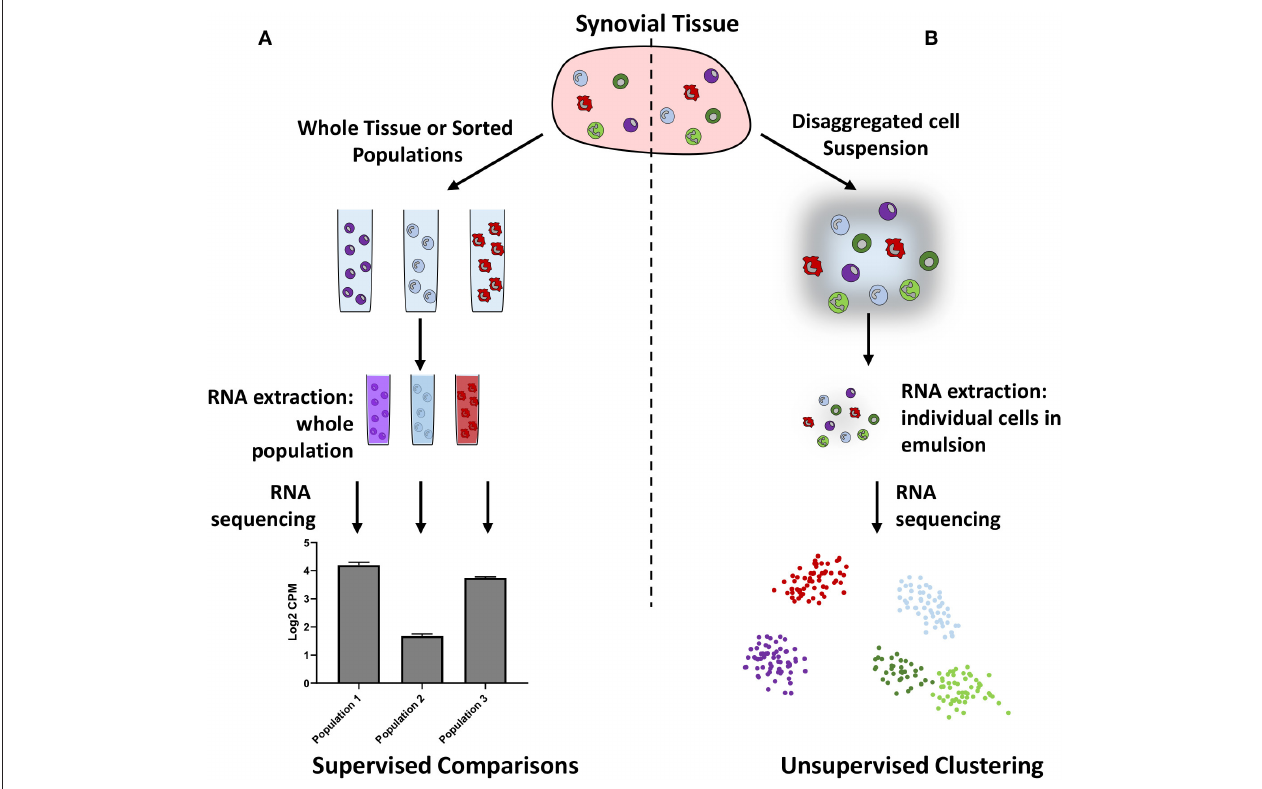
FIGURE 1 | Schematic illustrating bulk (A) vs. single cell (B) RNA sequencing. Bulk RNA sequencing requires researchers to preselect cellular populations or sequence whole samples, whereas single cell RNA sequencing does not require pre-selection and can be used to identify cellular populations in an unbiased